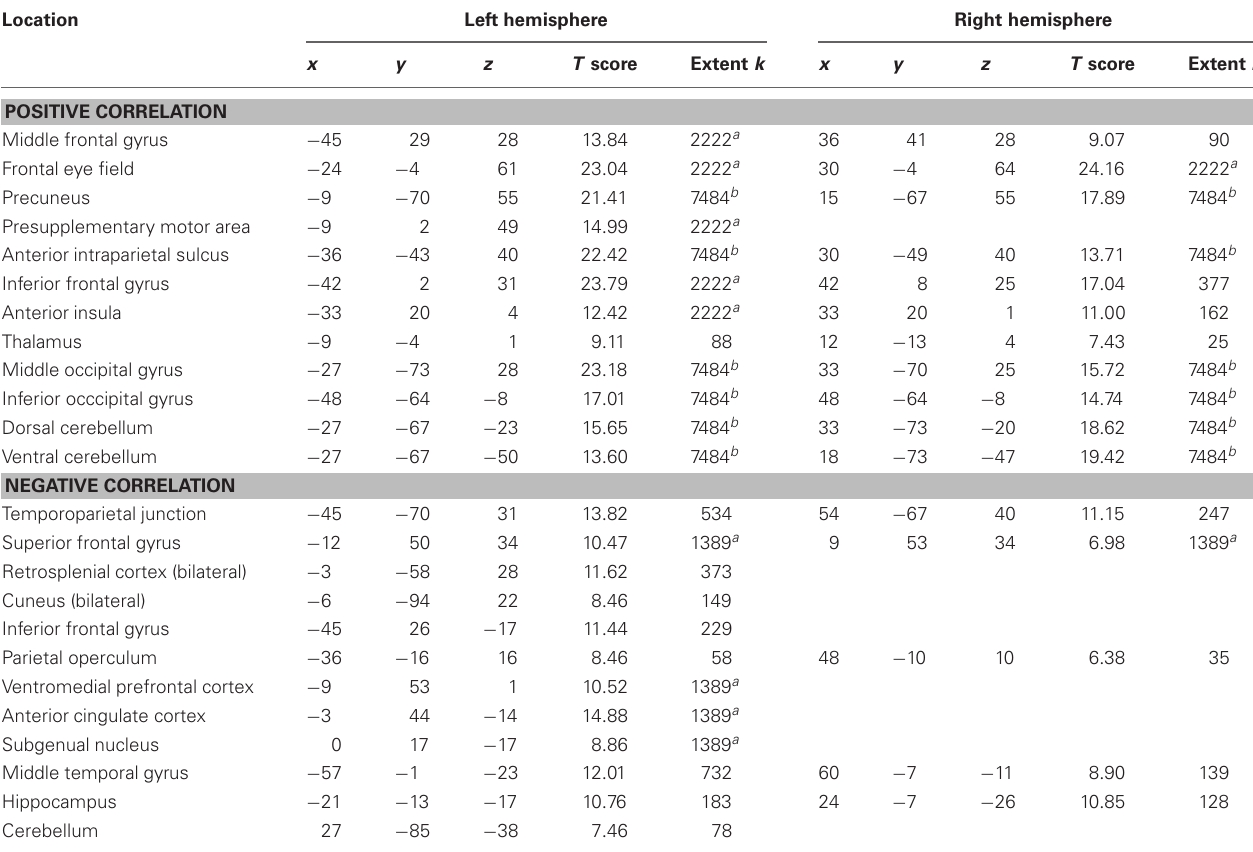
Table 4 | Brain areas in which activity correlates with joint performance error ( p < 0 . 05 corrected for family wise error, extent k > 25).